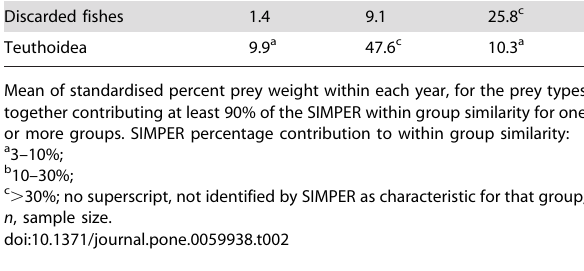
Mean of standardised percent prey weight within each fish weight (g) group, for the prey types together contributing at least 90% of the SIMPER within group similarity for one or more groups. SIMPER percentage contribution to within group similarity: a 3–10%; b 10–30%; c . 30%; no superscript, not identified by SIMPER as characteristic for that group; n , sample size.